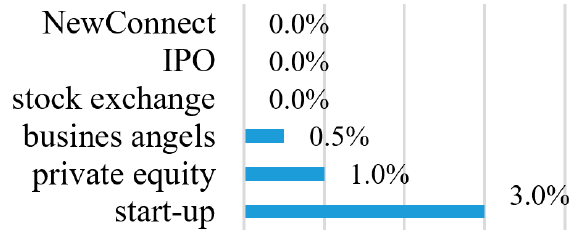
Figure 3. Use of alternative sources of financing by the respondents. Source: Own research.